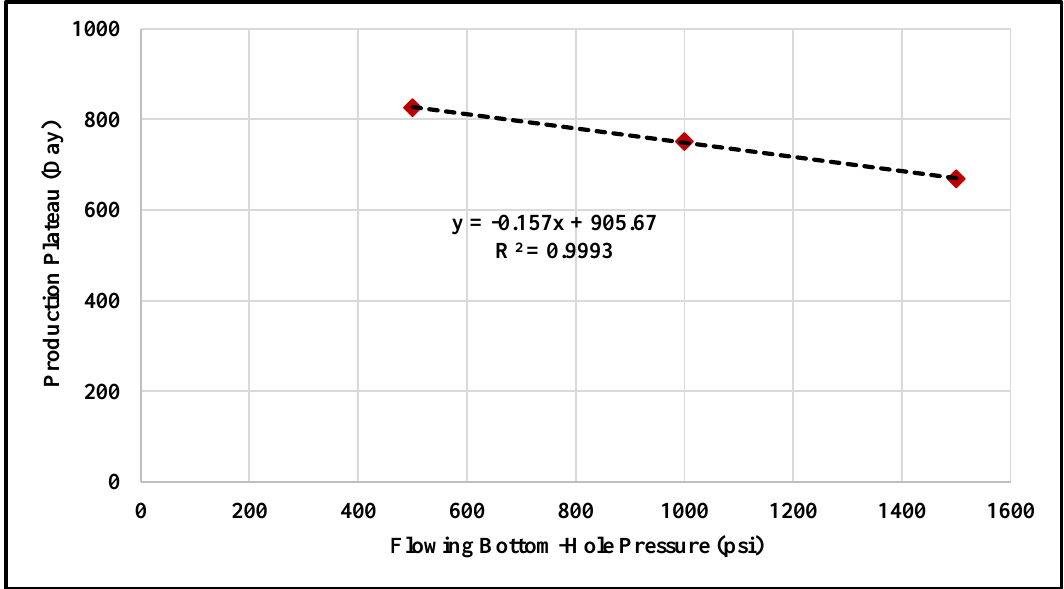
Figure 13. Profiles of gas-flow rates at different levels of flowing bottom-hole pressure.